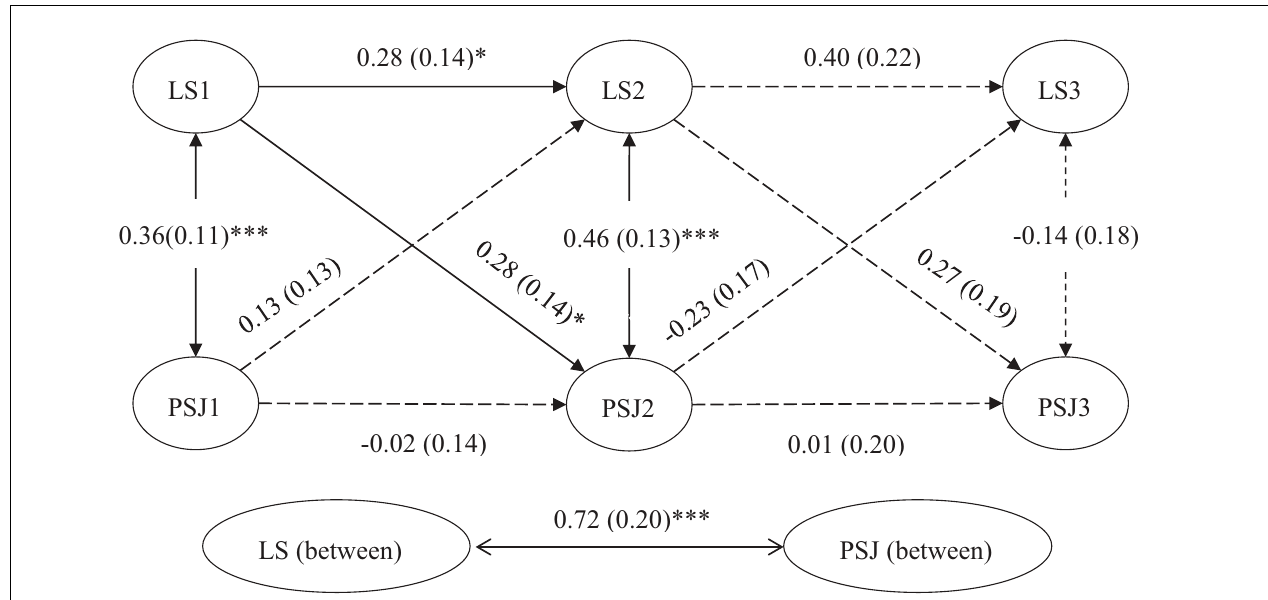
FIGURE 2 | Simplified random intercept cross-lagged panel model (RI-CLPM) in study 1. ∗ p < 0.05, ∗∗∗ p < 0.001. N = 119. LS 1–3 = life satisfaction of time 1 to time 3. PSJ 1–3 = perceived social justice of time 1 to time 3. Completely standardized parameter estimates are reported, with standard errors presented in